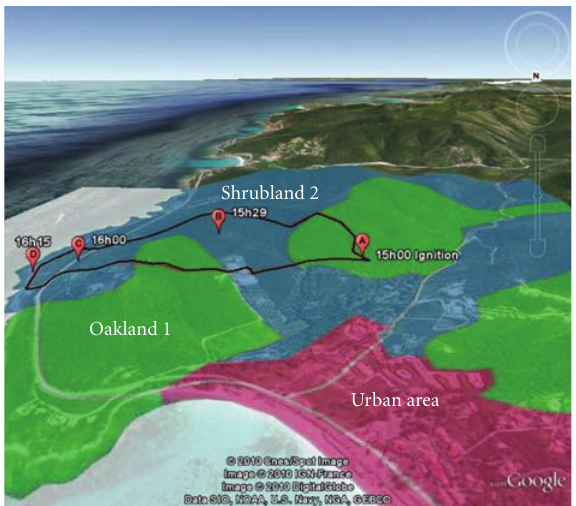
Figure 5: Topography, fire perimeter (in black) and vegetation types as defined in Table 1 for the case study of Favone